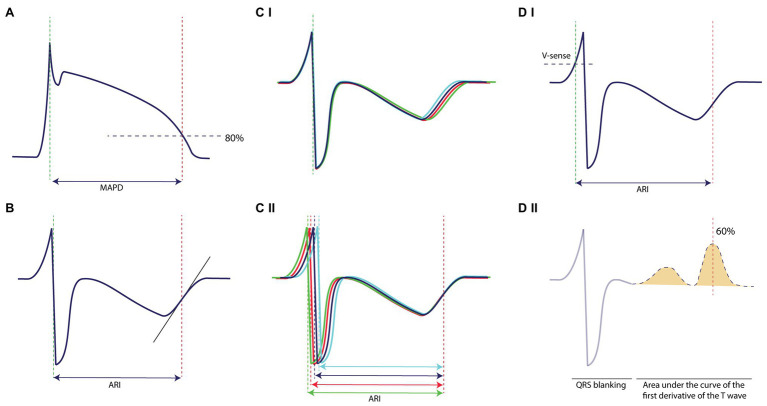
Methodology of measurement on the monophasic action potential and the electrogram. (A) STVMAPD is measured from the initial peak until 80% of repolarization. (B) STVARI measured with the slope method from the minimum dV/dt of the QRS-complex to the maximum dV/dt of the T-wave, irrespectively of the morphology of the T-wave. (C) (I) STVARI measured with fiducial segment averaging from the minimum dV/dt of the QRS-complex to (II) the maximum dV/dt of the T-wave, which also form the fiducial points of alignment. (D) STVARI measured with the new automatic method, (I) whereby ventricular sensing by conventional device methodology indicates the start of the determinant of repolarization and (II) the T-wave end is determined as 60% of the area under the curve of the first derivative of the T-wave.